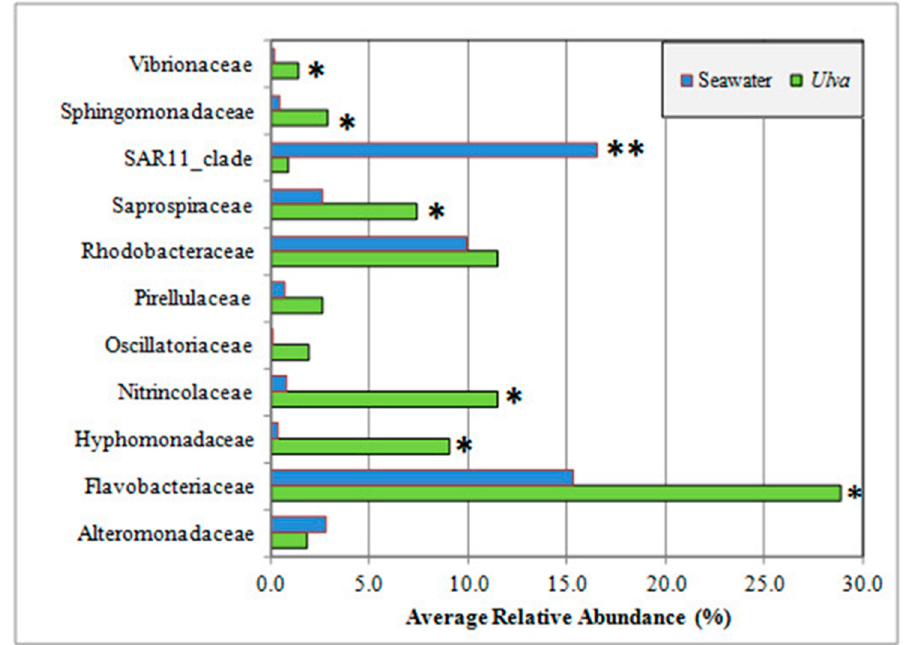
Figure 3. Average relative abundance of the most abundant seaweed-associated bacterial families compared with the same families identified in the surrounding seawater samples (significant one-way ANOVA values between matrices at p -value < 0.05 *, and p -value < 0.001 **.